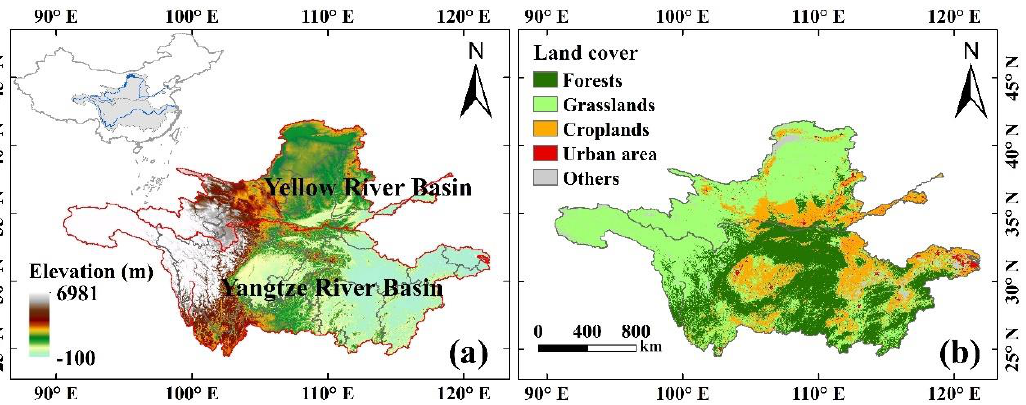
Figure 1. Location, elevation ( a ), and land cover types ( b ) of the Yellow River Basin and Yangtze River Basin.